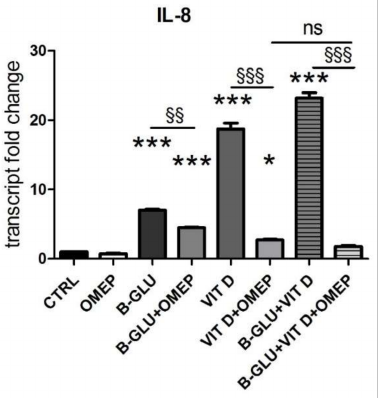
Figure 3. The immunomodulatory activity of beta-glucans and vitamin D is blocked by the inhibition of vacuolar acidification. U-937 cells were differentiated by TPA and were analyzed after 24 h of treatment with 100 µ g/mL beta-glucans (B-GLU) and 100 nM vitamin D (VIT D) in the presence or absence of 200 µ M omeprazole (OMEP). The transcript levels of IL-8 were measured by real-time PCR. Results are expressed relative to control and as the means ± SEM. * P < 0.05 and *** P < 0.001 vs. ctrl; §§ P < 0.01 and § §§ P < 0.001. ns: not significant.